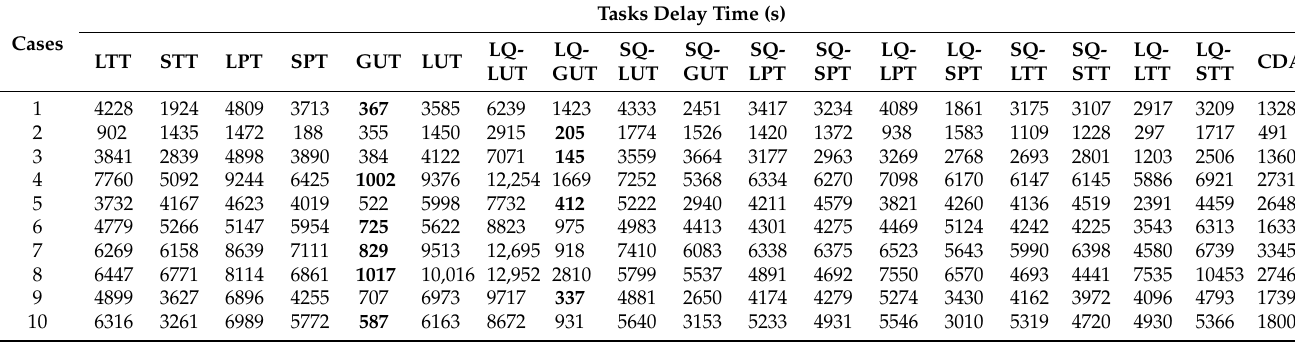
Table A2. Tasks delay time of CDA algorithm and assignment rules under different